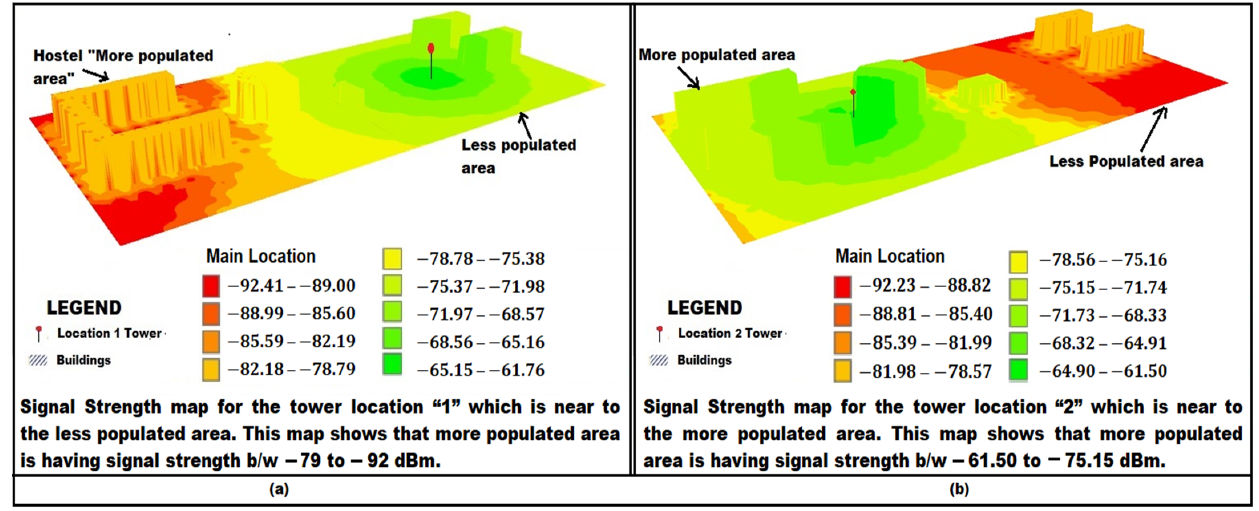
Figure 14. ( a ) Signal strength map for cell tower location “1”. ( b ) Signal strength map for cell tower location “2”.